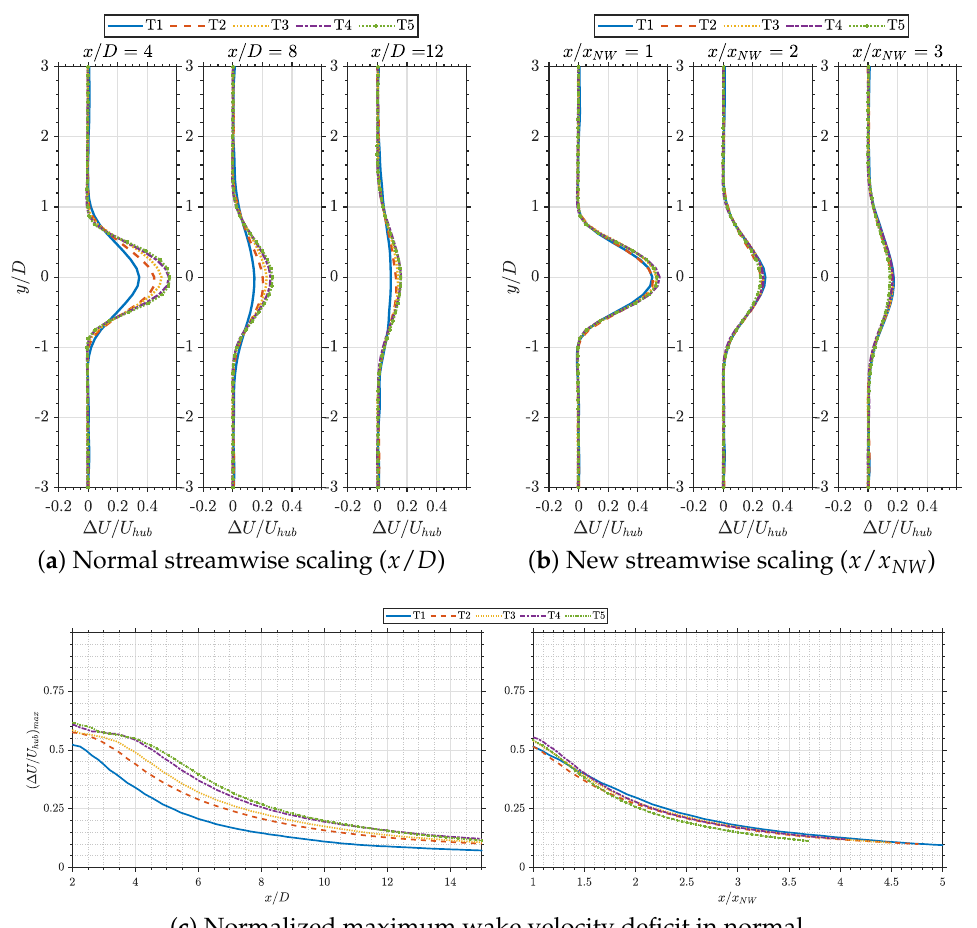
Figure 4. Evaluating the research question: comparison of the lateral wake velocity deficit profiles in ( a ) normal streamwise scaling and ( b ) new streamwise scaling; ( c ) comparison of the normalized maximum wake velocity deficit behaviour under two different streamwise